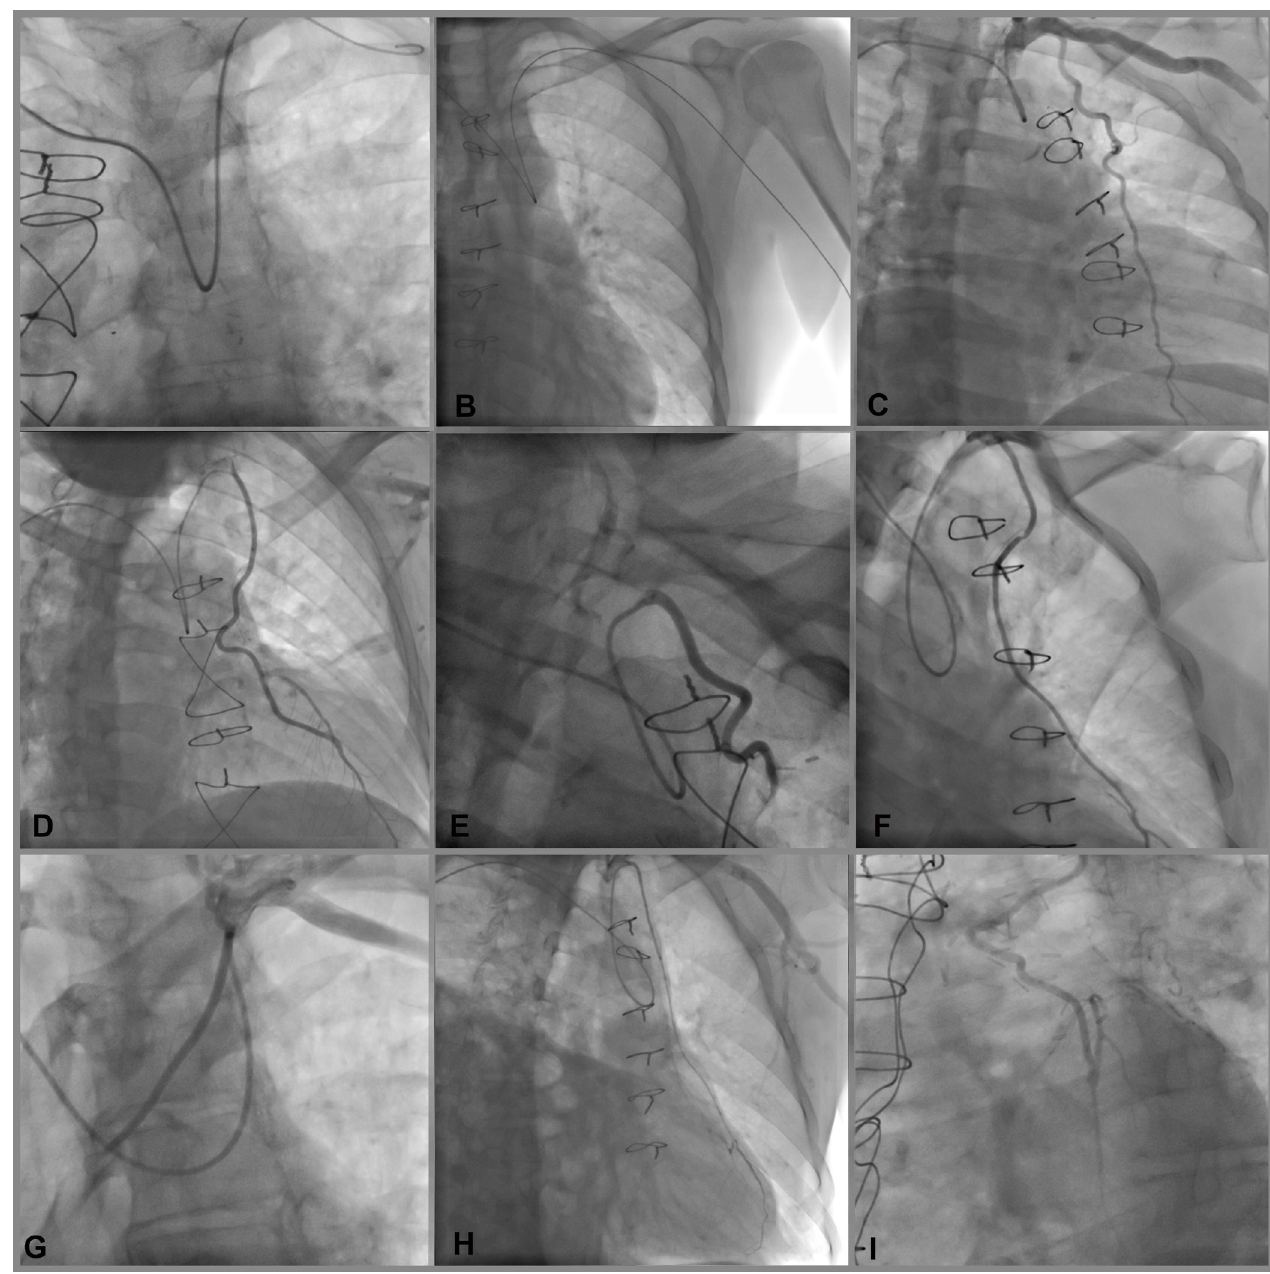
Fig. 2 – The left internal mammary artery (LIMA) angiography with right transradial access. A, B: The 0.35 guidewire and catheter moving forward from right radial artery to left subclavian artery for LIMA imaging. C, D, E, F, G, H, I; LIMA angiography images with right transradial